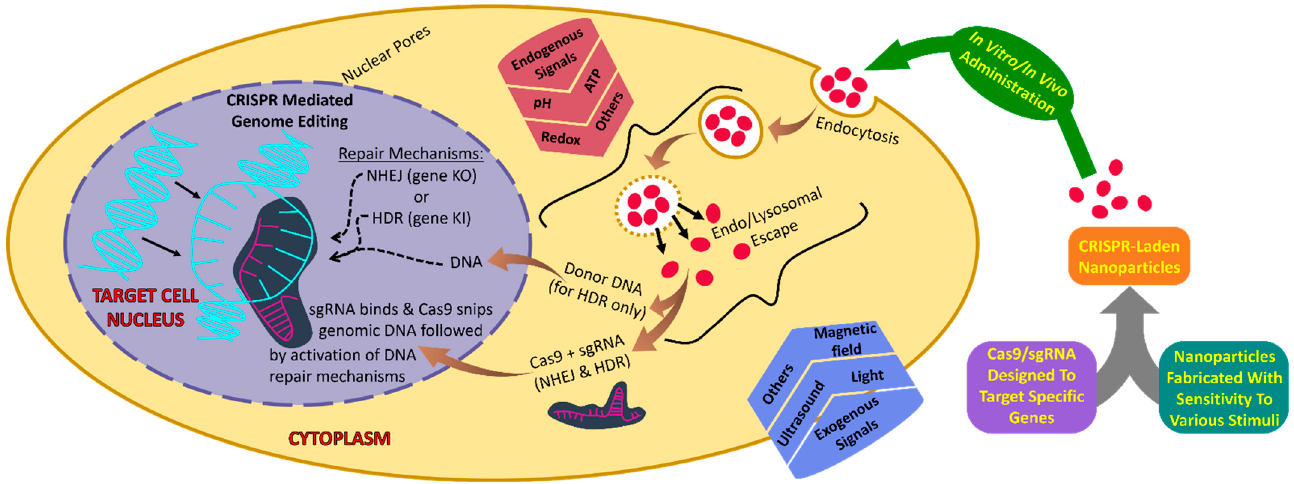
Figure 1. Schematic illustration of smart NPs stimulus-responsive-based CRISPR/Cas9 delivery.